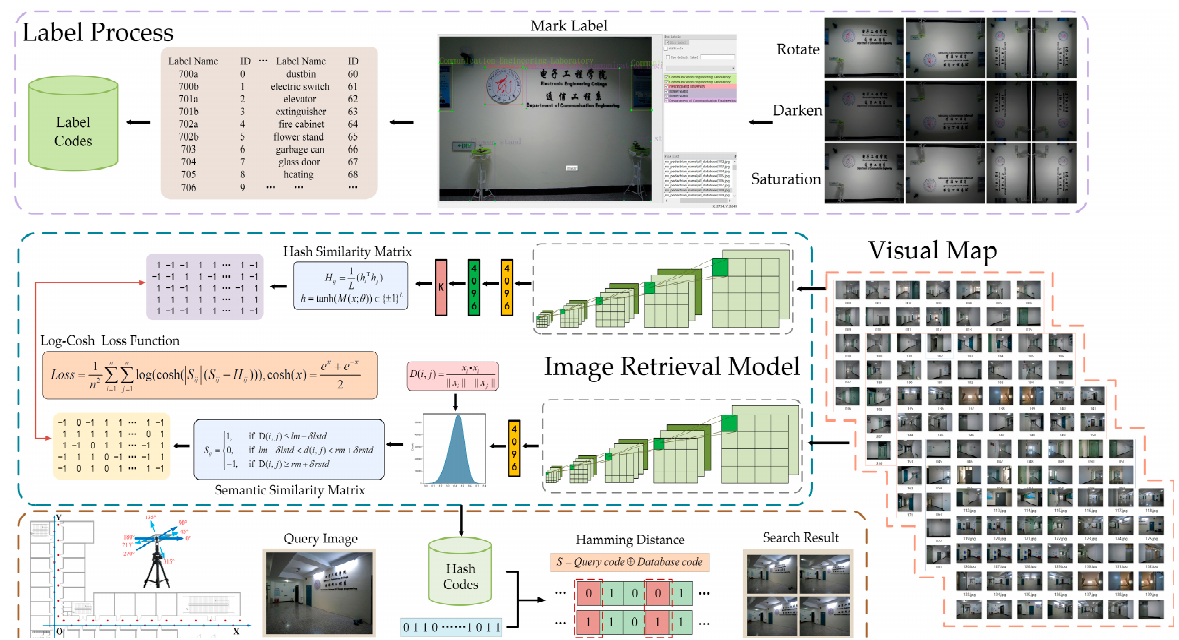
Figure 6. Flowchart of image retrieval based on deep hashing.